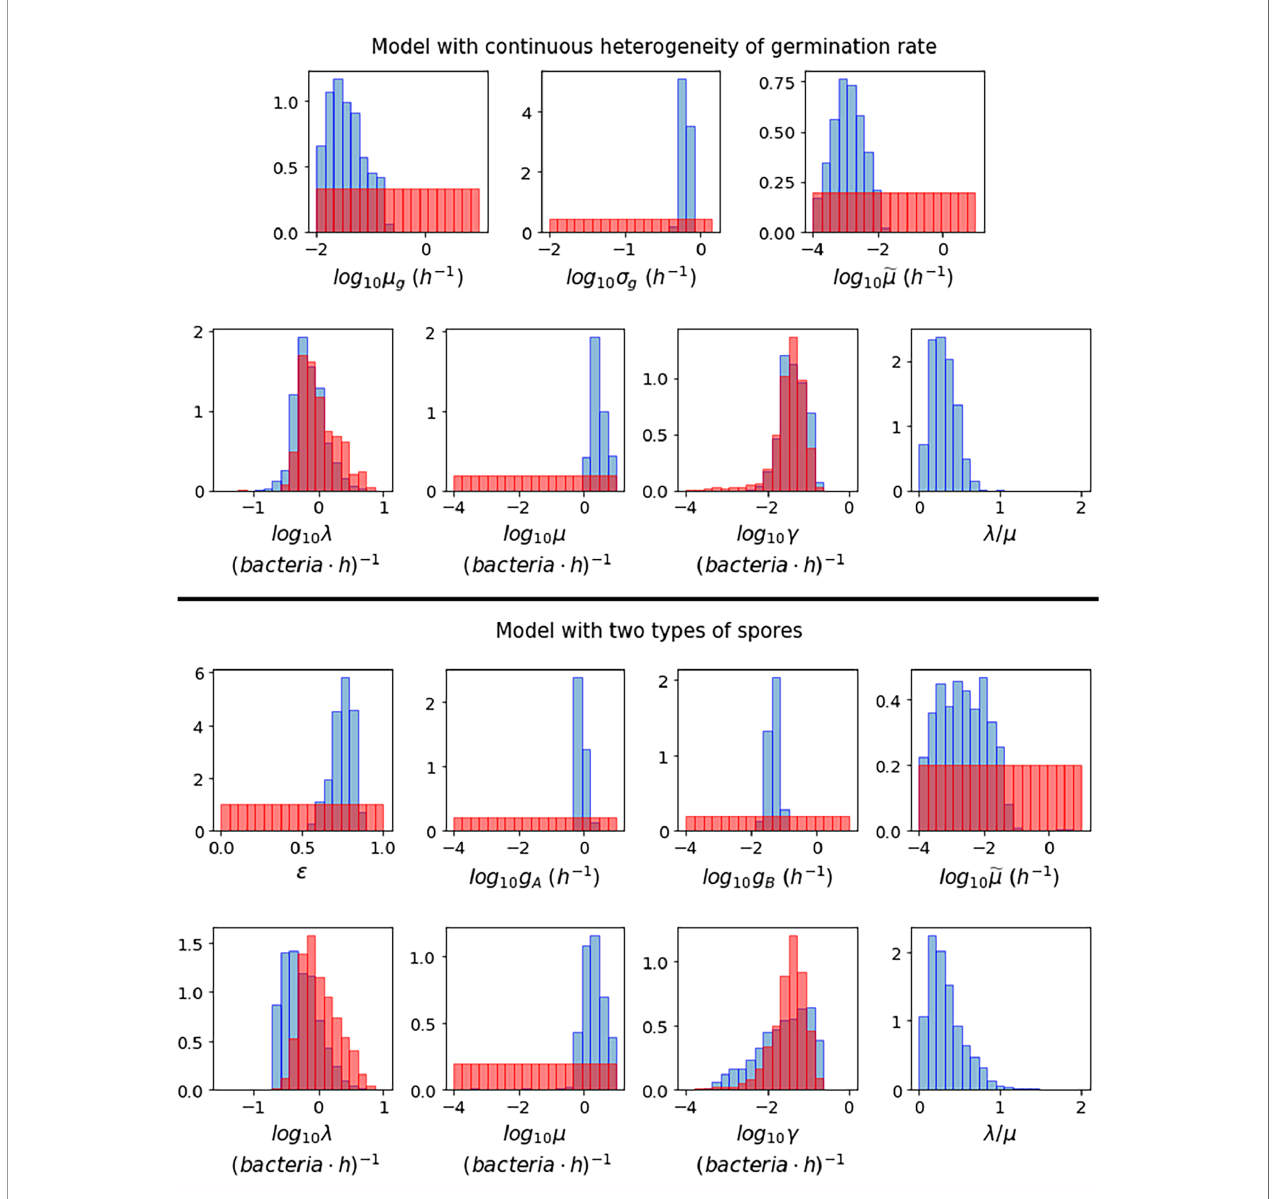
FIGURE 3 | Prior distributions (red) and posterior histograms (blue) when performing ABC-SMC for the model with continuous heterogeneity of germination rate (top), and the model with two types of spores (bottom), using data from (23) of the number of intracellular spores and bacteria at different time points for MOIs 1:2, 1:10 and